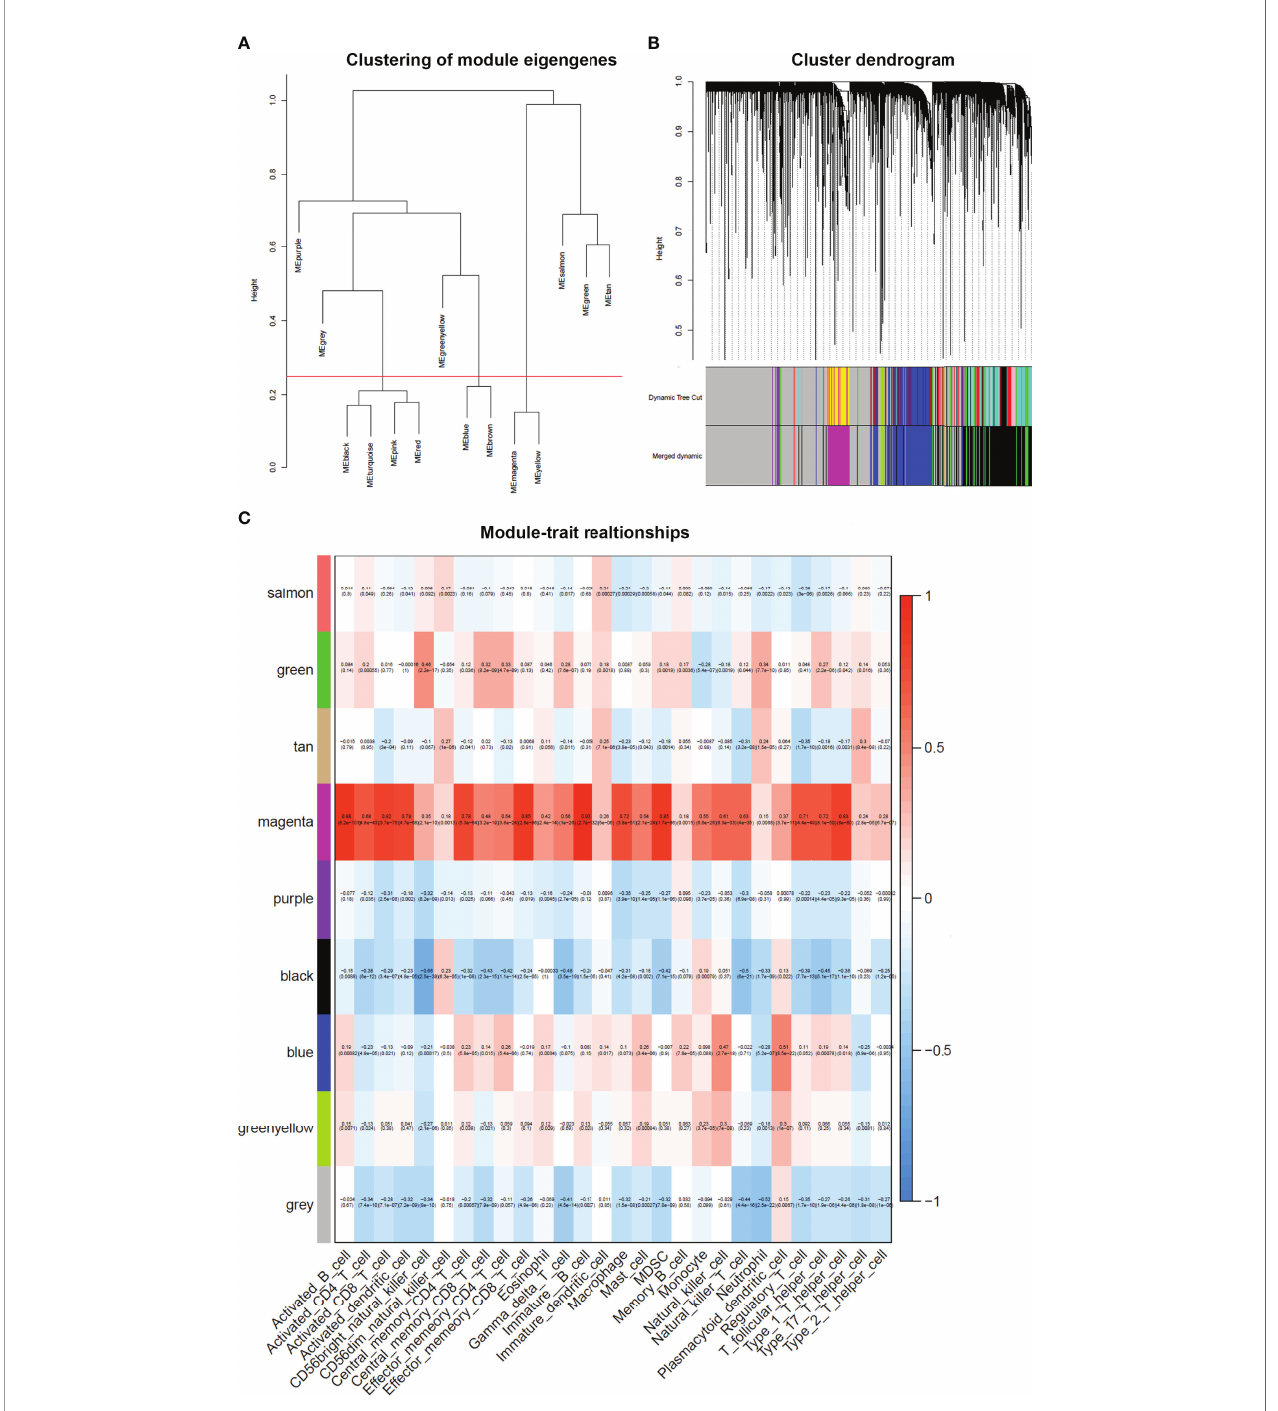
FIGURE 5 | Weighted gene co-expression network in cervical cancer. (A) Clustering of module eigengenes. A cutline (0.25) was selected for module dendrogram and merged some modules according to dissimilarity of estimated module eigengenes. (B) A dendrogram of the differentially expressed genes clustered based on different metrics. Each branch in the fi gure represents one gene, and everycolor below represents one co-expression module. (C) A heatmap showing the correlation between the gene moduleand clinicaltraits. The correlation coef fi cientin each cell representedthe correlation between gene moduleandthe clinical traits. The magenta module showed the highest correlatedwith the in fi ltratedimmune